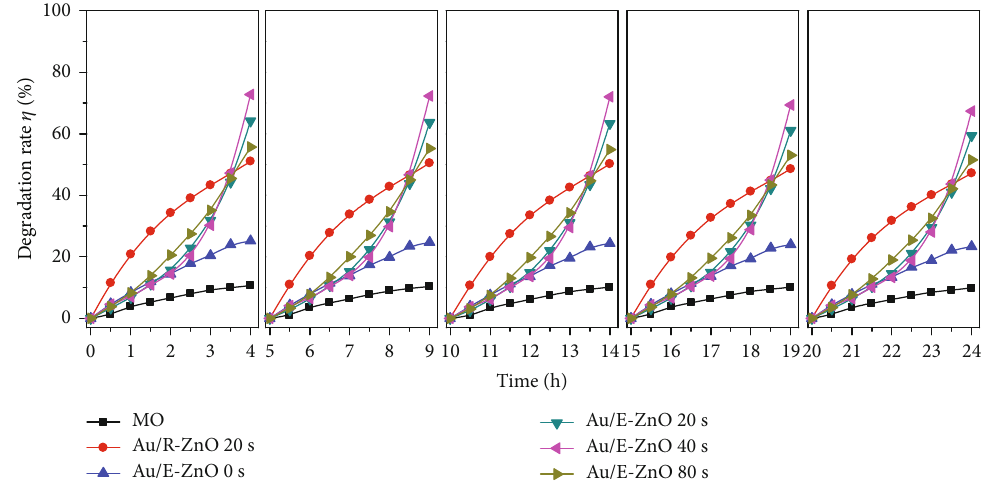
Figure 15: Cyclic photodegradation e ffi ciency of methyl orange (MO), the Au/R-ZnO 20s, and Au/E-ZnO Schottky heterojunctions with di ff erent deposition times (0 s, 20 s, 40 s, and 80s) irradiated with UV lamp under the same condition fi ve times, respectively.